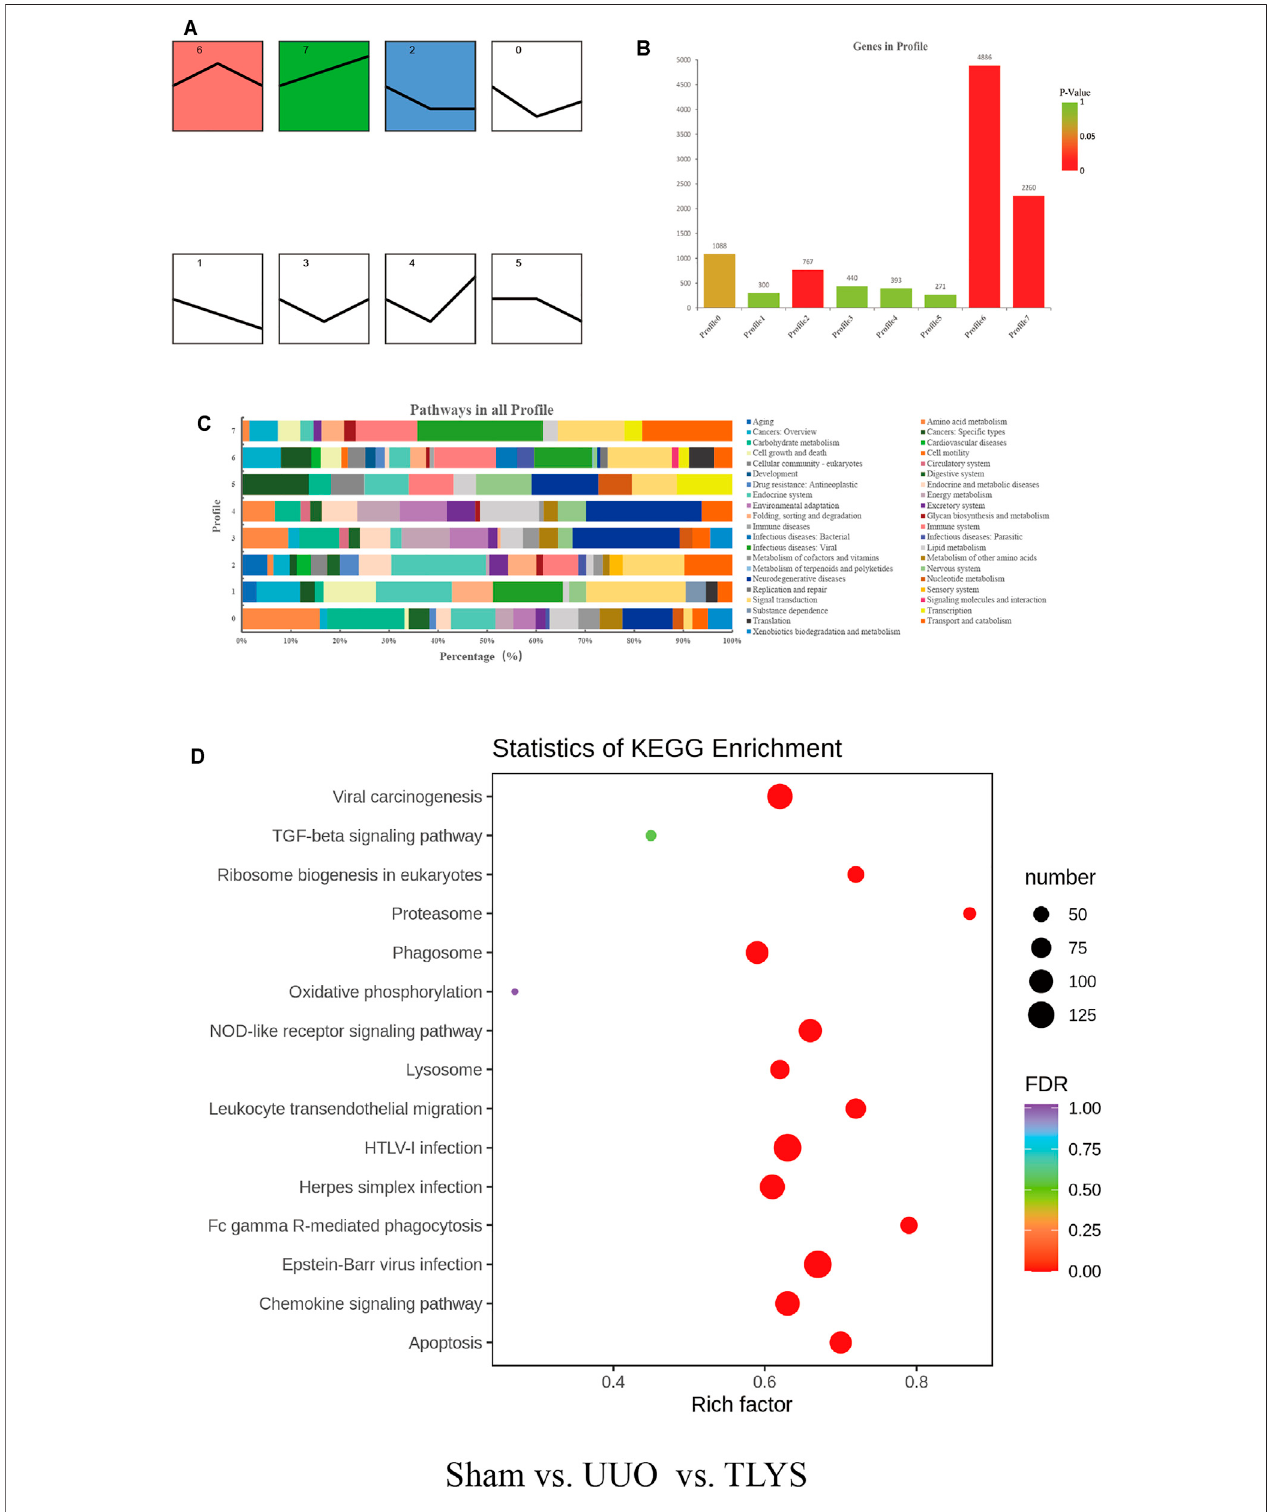
FIGURE 5 | TLYS decoction may be related to mitochondria and mitophagy in UUO rats. (A) All trends (pro fi le 0 – 7) of genes with signi fi cant differences. (B) Histogramofthefourtrends(red)withsigni fi cantdifferences, p < 0.05. (C) Pathway-relatedgenedistribution(%)inallpro fi les. (D) BubblediagramofKyotoEncyclopedia of Genes and Genomes (KEGG) pathway enrichment. Three independent samples were tested in each experimental group.